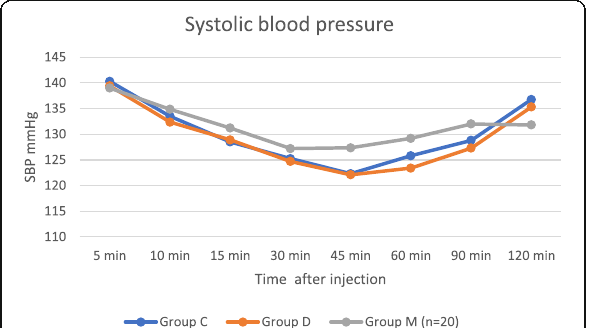
Fig. 2 Linear chart of systolic blood pressure between the three groups Fig. 3 Linear chart of heart rates between the three